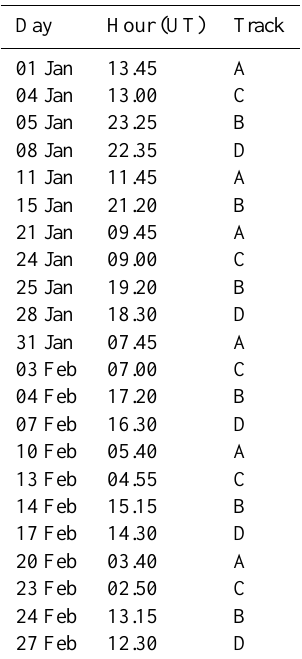
Table 1. Days and hours corresponding to the TOPEX-POSEIDON passes along the tracks A, B, C, and D of Fig.